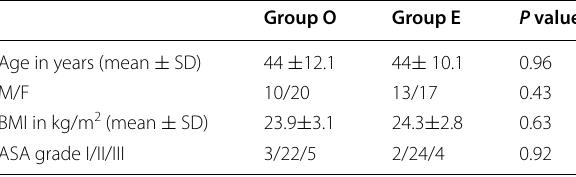
Table 1 Demographic Characteristics and ASA